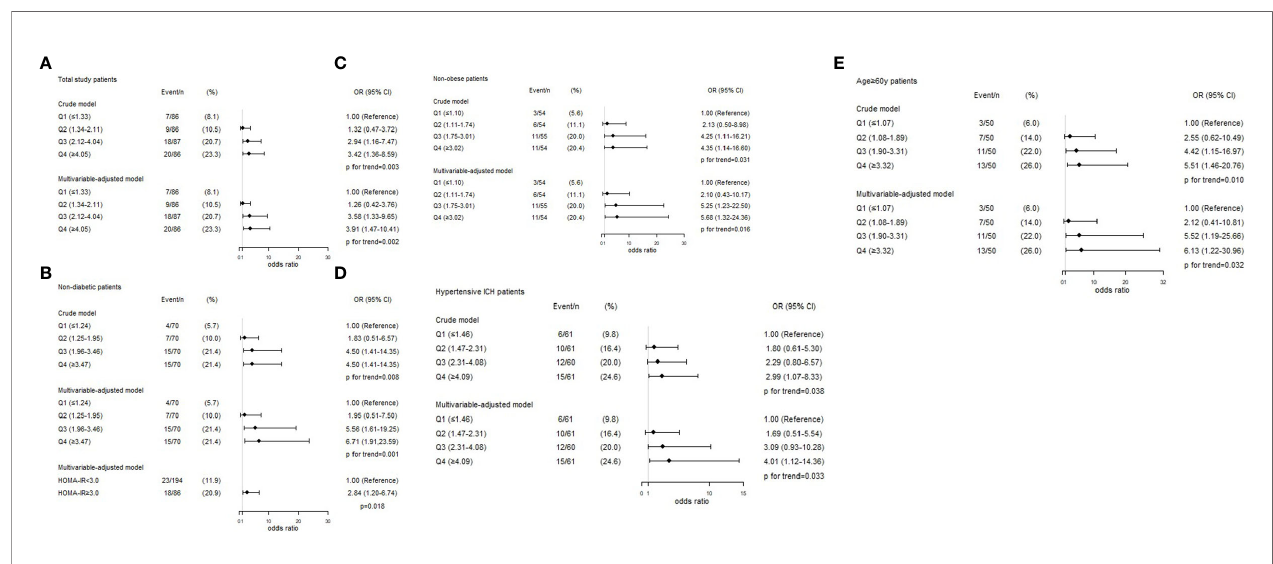
FIGURE 3 | Associations between HOMA-IR index and the presence of R-DWILs in total study patients (A) , non-diabetic patients (B) , non-obese patients (C) , hypertensive ICH patients (D) and age ≥ 60y patients (E) . ORs and 95% CIs of R-DWILs occurrence are shown according to HOMA-IR quartiles in each group. The multivariable-adjusted models were adjusted for age (not for age ≥ 60y patients group), gender, body mass index (not for non-obese patients group), National Institutes of Health Stroke Scale score, history of hypertension, history of diabetes mellitus (not for non-diabetic patients group), ventricle extension, total cerebral small vessel disease score and antiplatelet use. OR indicates odds ratio; CI, con fi dence interval; Q, quartile; HOMA-IR, homeostasis model assessment of insulin resistance; R-DWILs, remote diffusion-weighted imaging